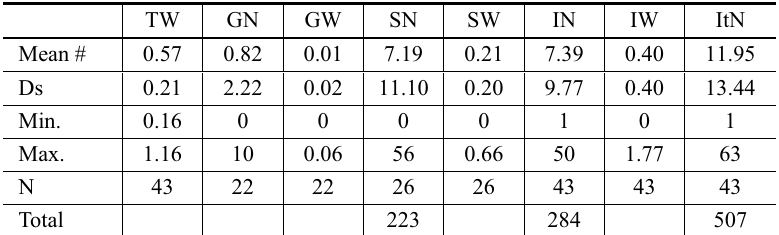
Mean summer dietary items values of Embernagra platensis at the Laguna de Guaminí during December